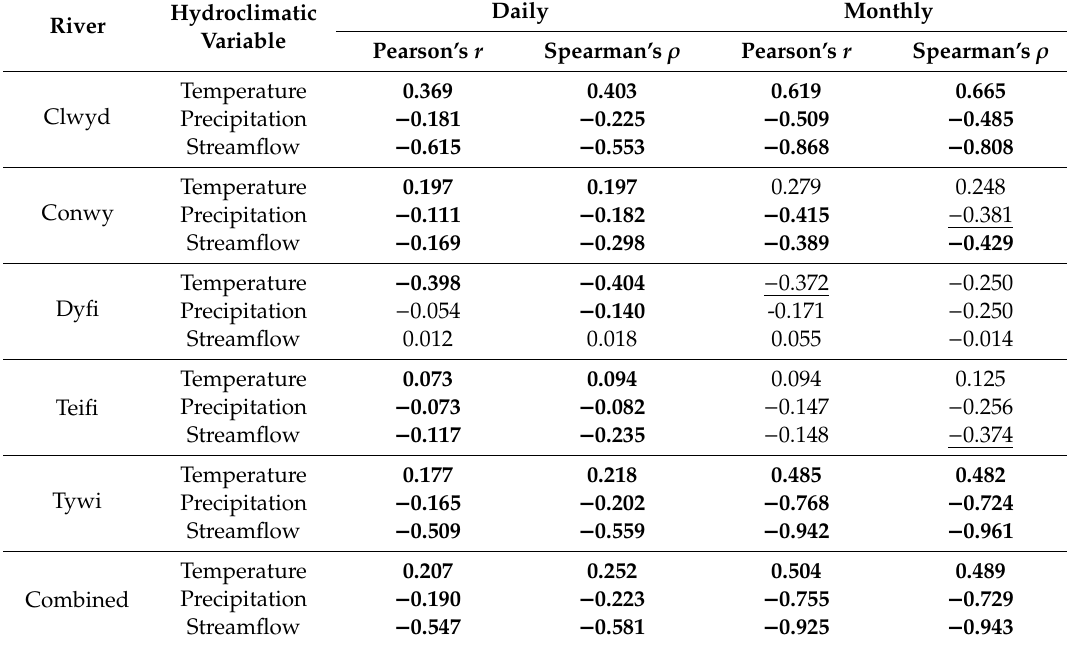
Table 6. Pearson’s and Spearman’s rank correlation coe ffi cient results for daily and monthly abstraction data with hydroclimatic factors (2012–2015). Statistics relating to a combined analysis of total daily / monthly abstraction in all catchments with average daily / monthly temperature, total streamflow volume and total precipitation volume across all catchments is also provide. Values for r and ρ underlined are significant at p < 0.05, and those in bold are significant at p < 0.01. Hydroclimatic River Variable